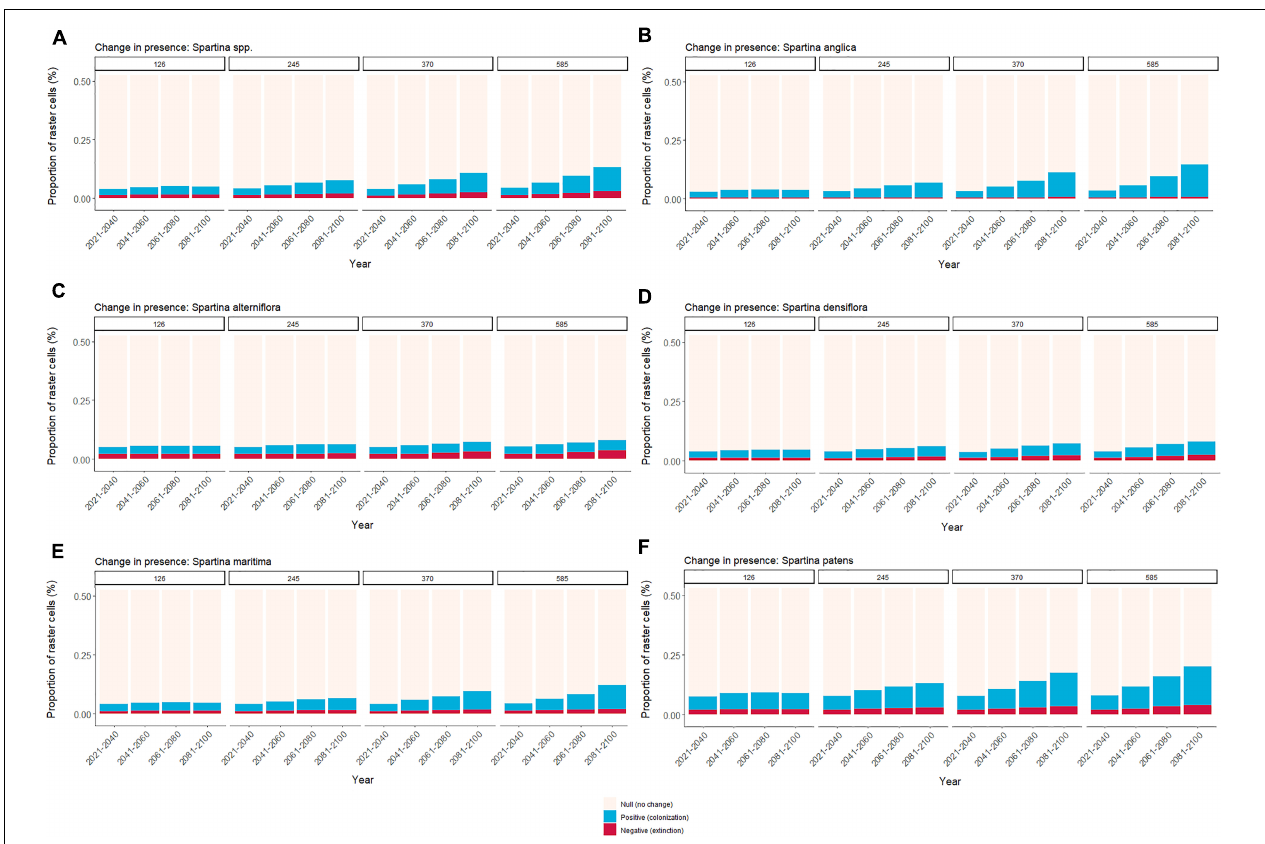
FIGURE 5 | Relative change (colonization or extinction potential) or no change in presence over time (per period, until 2100), given in proportion of raster cells (%) with positive, negative, and null values, across specific CMIP6 Shared Socioeconomic pathways (i.e., SSP1-2.6, 2-4.5, 3-7.0, and 5-8.5), for (A) the whole genus, (B) Spartina anglica (C) Spartina alterniflora (D) Spartina densiflora (E) Spartina maritima , and (F) Spartina patens